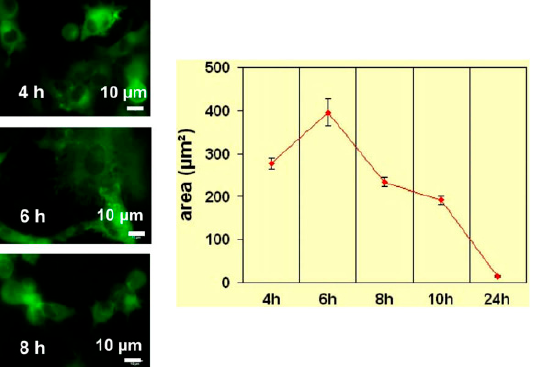
Figure 1. Comparison diagram of newly-born bone cells coated with ( a , b ) calcium phosphate around the culture. Reprinted with permission from Ref. [24]. Copyright 2019 Copyright Elsevier.